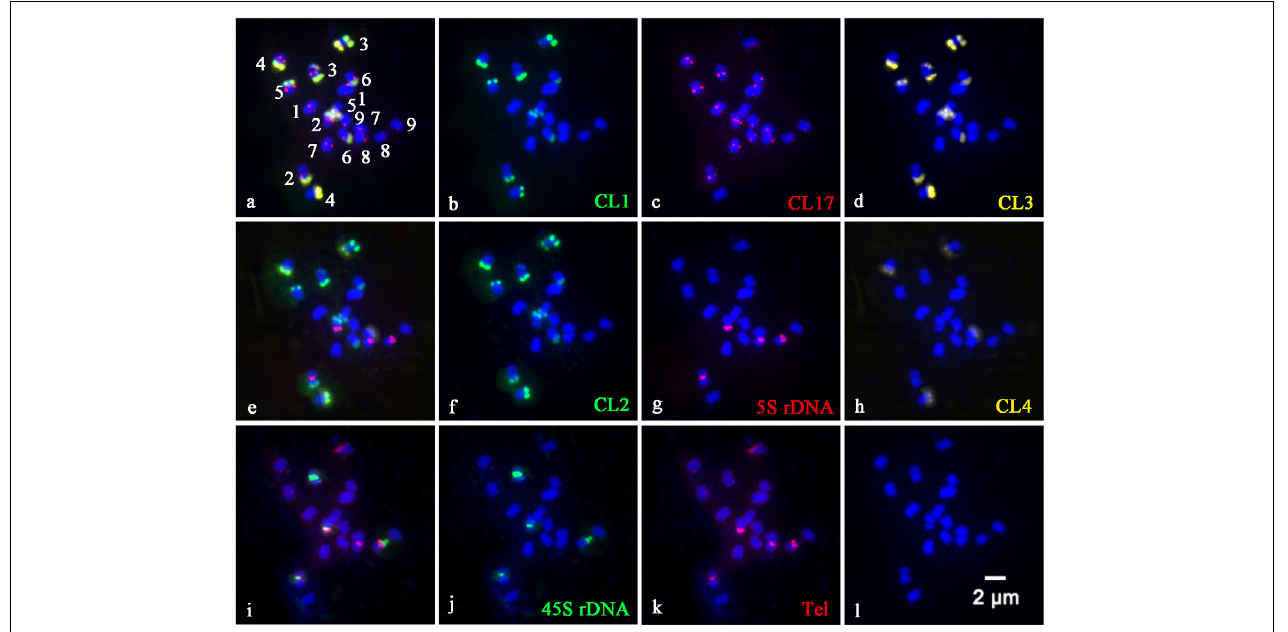
FIGURE 1 | Physical localization of different highly repetitive DNA sequences on root tip metaphase chromosomes of diploid Carrizo Citrange rootstock. The merged images of (a) , (e) , and (i) came from the hybridization sites in (b–d) , (f–h) , and (j,k) , respectively. (b) Satellite repeat CL1 (green), (c) a centromere-like repeat CL17 (red), (d) satellite repeat CL3 (yellow), (f) satellite repeat CL2 (green), (g) 5S rDNA (red), (h) satellite repeat CL4 (yellow), (j) 45S rDNA (green), and (k) telomere repeat (red) were used as FISH probes. Signal color corresponds to probe name in (b–d,f–h,j,k) . (l) DAPI-stained chromosomes were converted into a blue image. Bar = 2 µ m.